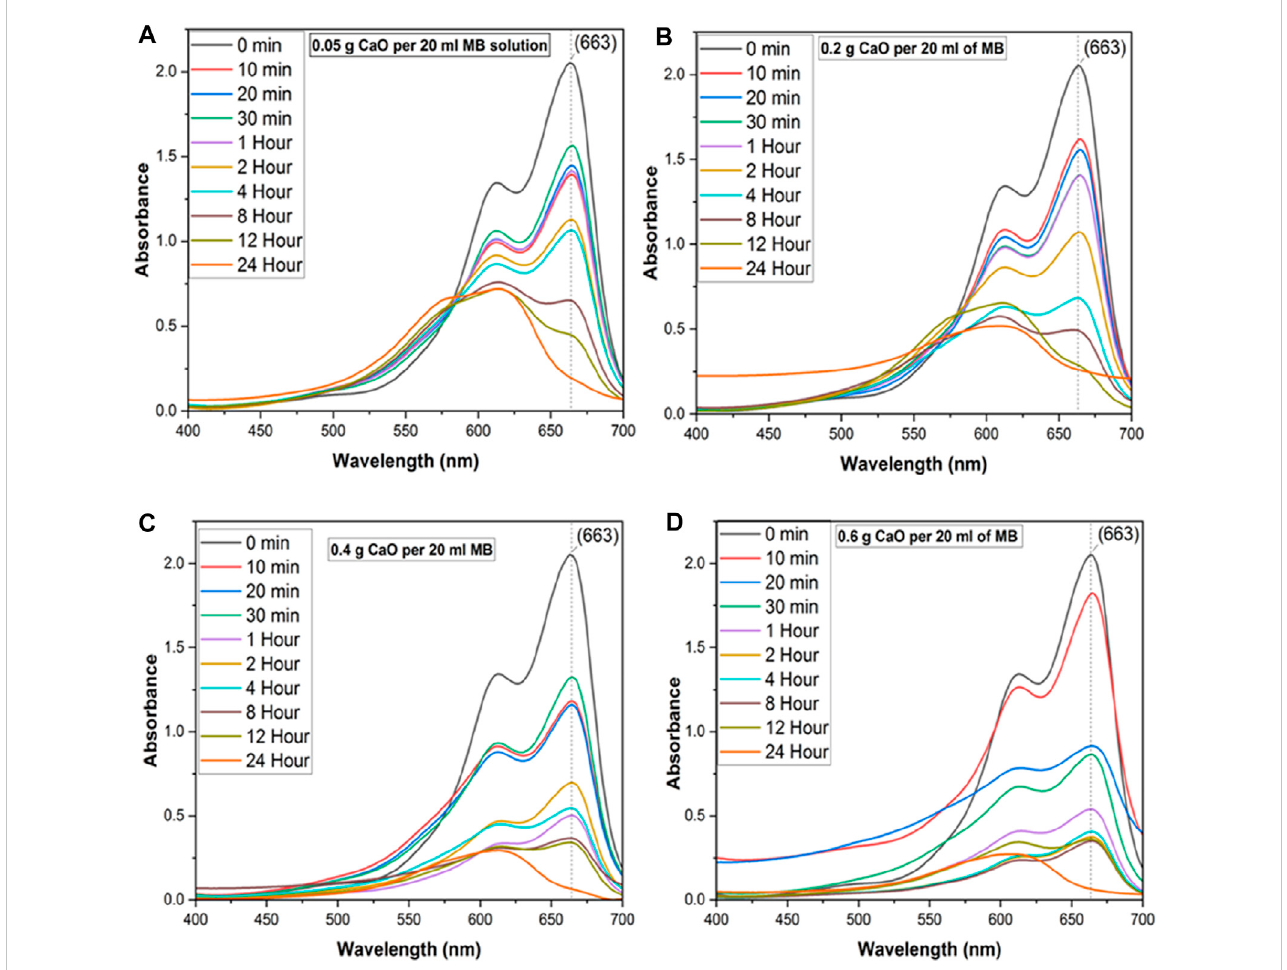
UV-Vis spectrum of MB on different CaO bio sorbent dosage for different contact time, (A) UV-Vis spectra of methylene blue with 0.05 g CaO/20ml MB solutionupto24Hourtime, (B) UV-Visspectraofmethylenebluewith0.2gCaO/20mlMBsolutionupto24h, (C) UV-Visspectraofmethylenebluewith0.4 g CaO /20 ml MB solution up to 24 h and (D) UV-Vis spectra of methylene blue with 0.6 g CaO/20 ml MB solution up to 24